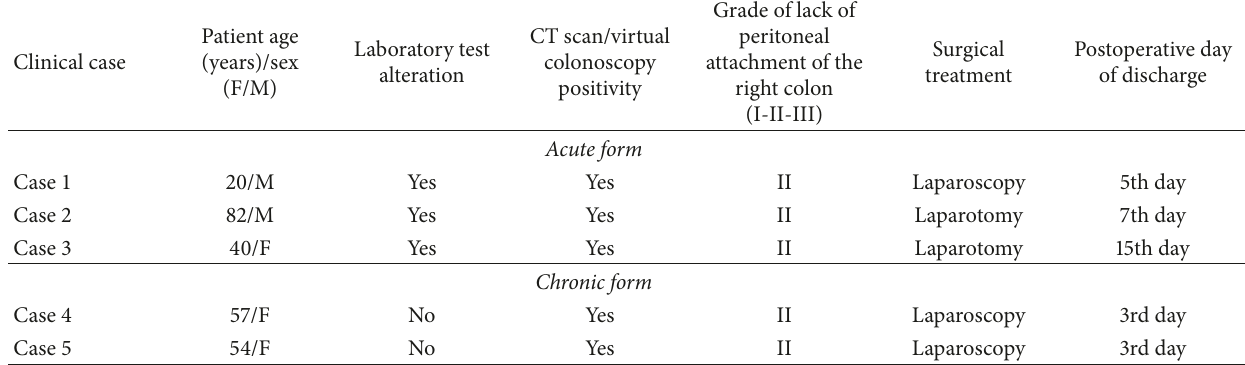
Table 1: Summary of clinical cases’